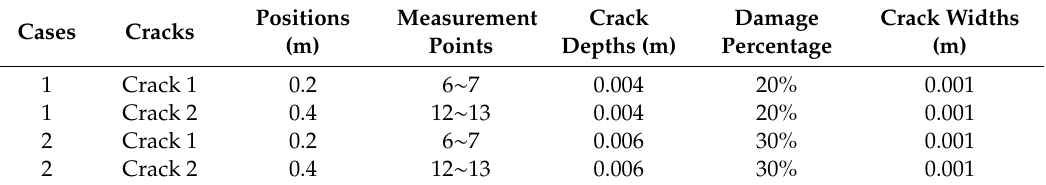
Table 3. Crack parameters of the two damage